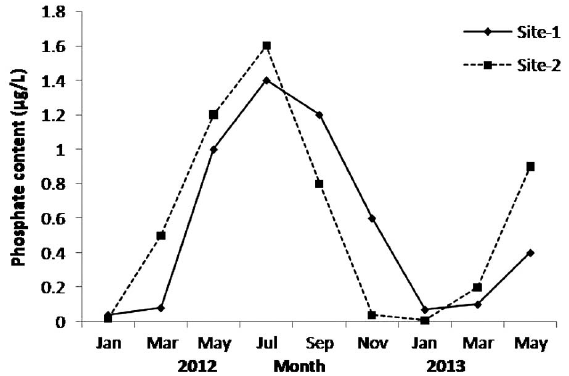
Fig. 8. – Seasonal variations in phosphate content of seawater at Site 1, Payyannur (PNR), and Site 2, Panambur (PNBR).